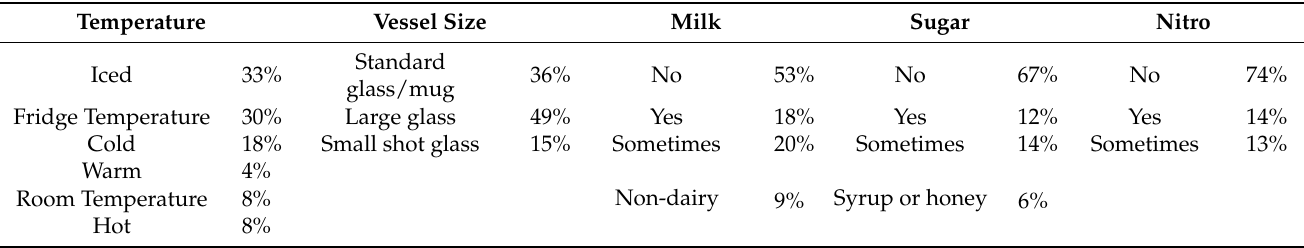
Table 3. Survey result of the different methods to serve cold brew coffee.